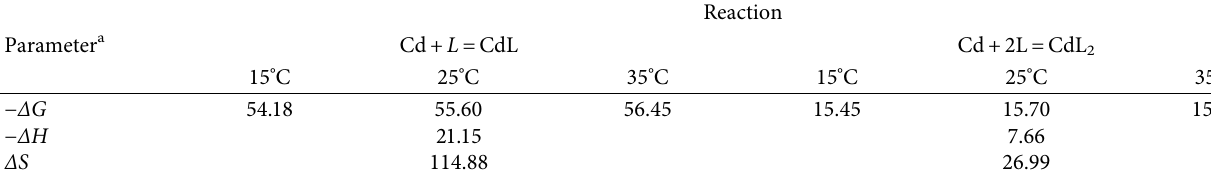
Table 8: Thermodynamic parameters for Cd (II)-TSC1 complexes in 50% DMSO-H Parameter a